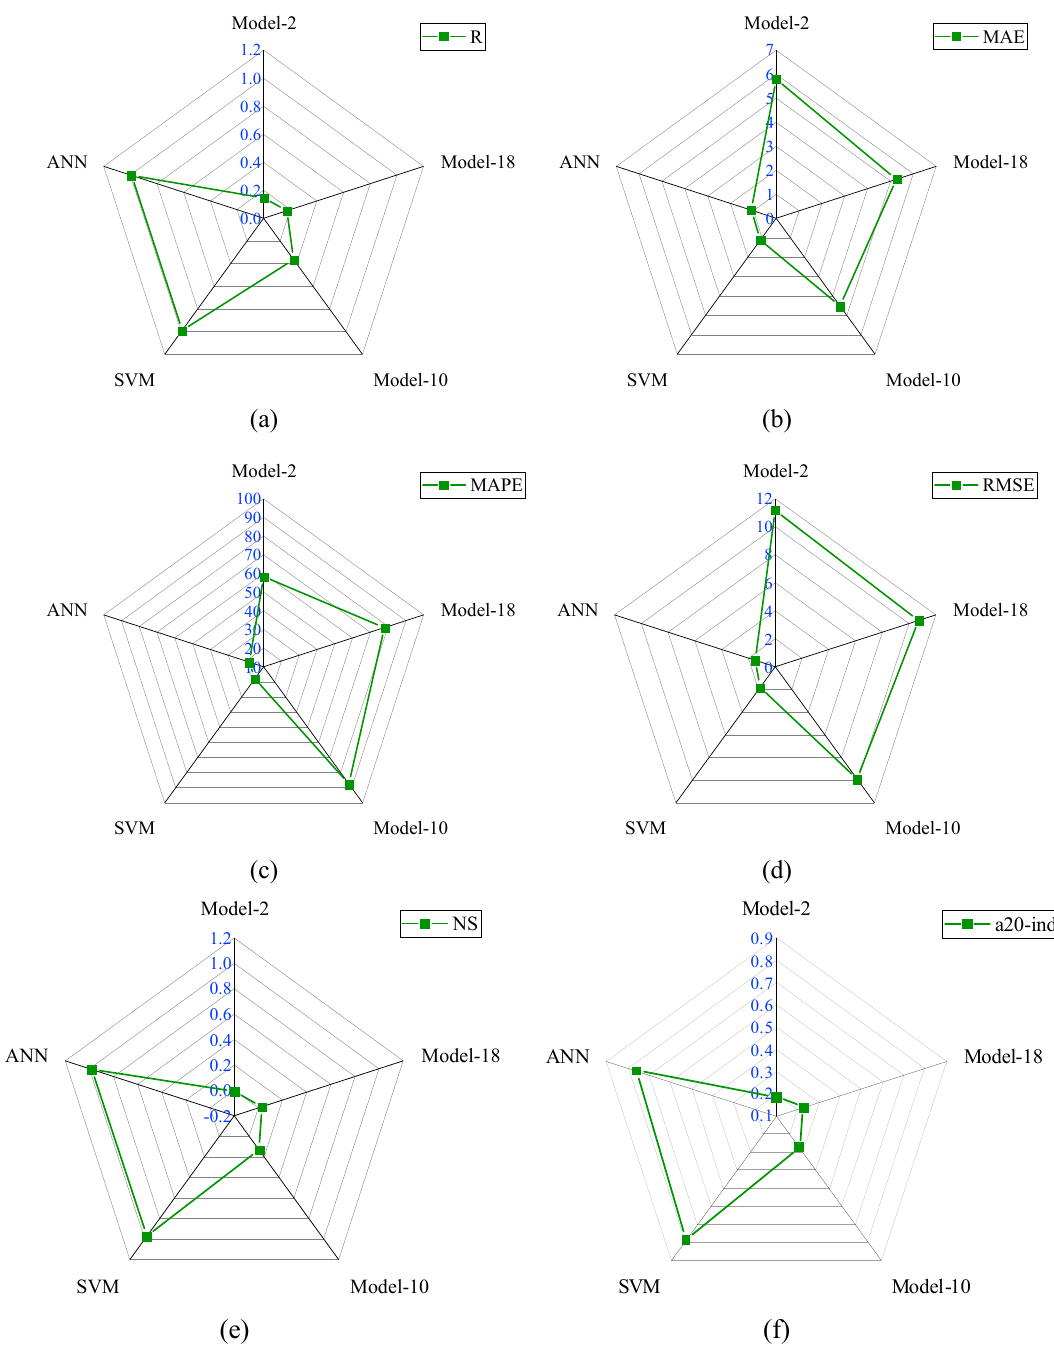
Figure 13. Comparison of performance indices of best-fitted model from each group with proposed SVM and ANN models; ( a ) R, ( b ) MAE, ( c ) MAPE, ( d ) RMSE, ( e ) NS, ( f ) a-20 index. In essence, the Taylor diagram is a form of mathematical graphic representation where the baseline indicates that the R-value is one, and the RMSE value is zero, as dis- played in Figure 14.